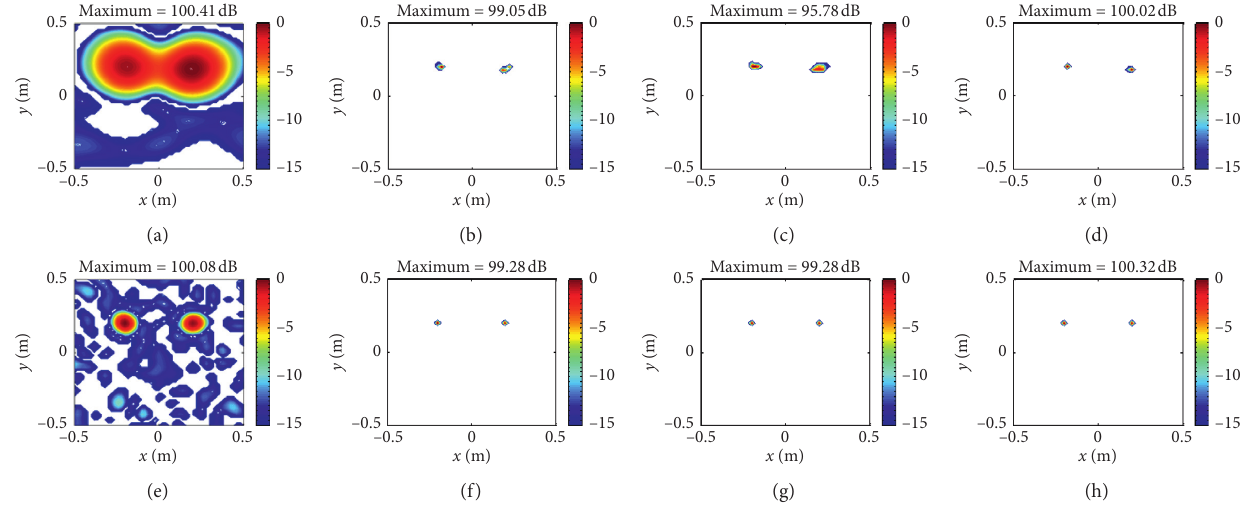
Figure 3: Contour maps of SPLs at 1 m distance from the source using different algorithms at a 10dB SNR. (a) CB at 2000Hz; (b) SC- DAMAS at 2000Hz; (c) FISTA at 2000Hz; (d) SFISTA at 2000Hz; (e) CB at 6000Hz; (f) SC-DAMAS at 6000Hz; (g) FISTA at 6000Hz; (h) SFISTA at 6000Hz.